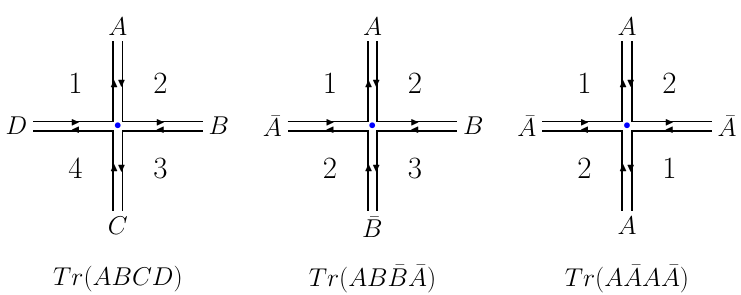
Figure 8 . Matrix model vertices. Each is the dual counterpart of the corresponding three square types represented in (cid:12)gure 6.